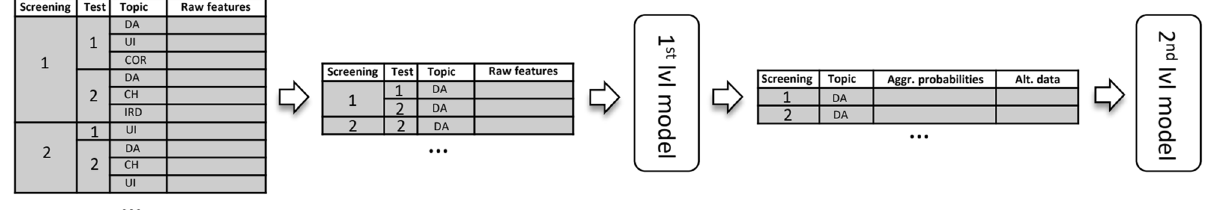
Figure 4. One-topic model scheme.